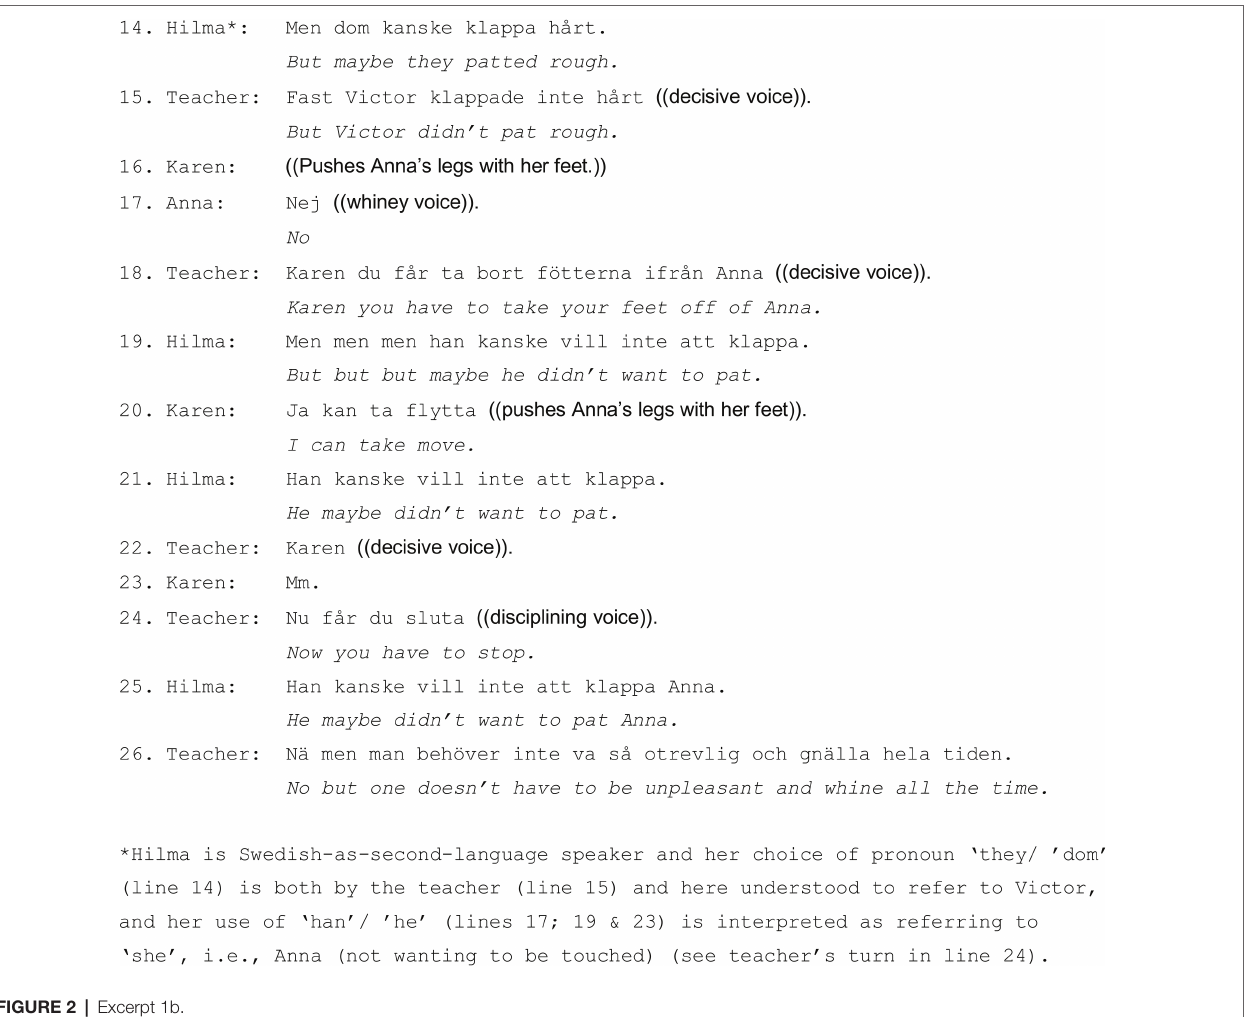
FIGURE 2 | Excerpt